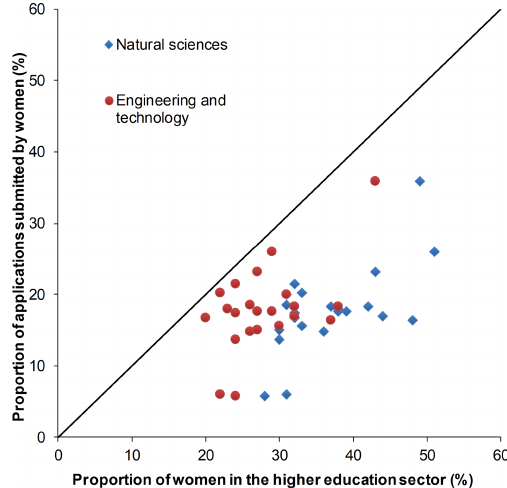
Figure 1. Successful applications (% of all applications) for women and men per country for the ERC PE panels 2012–2018 in countries with at least 50 applicants during that period.